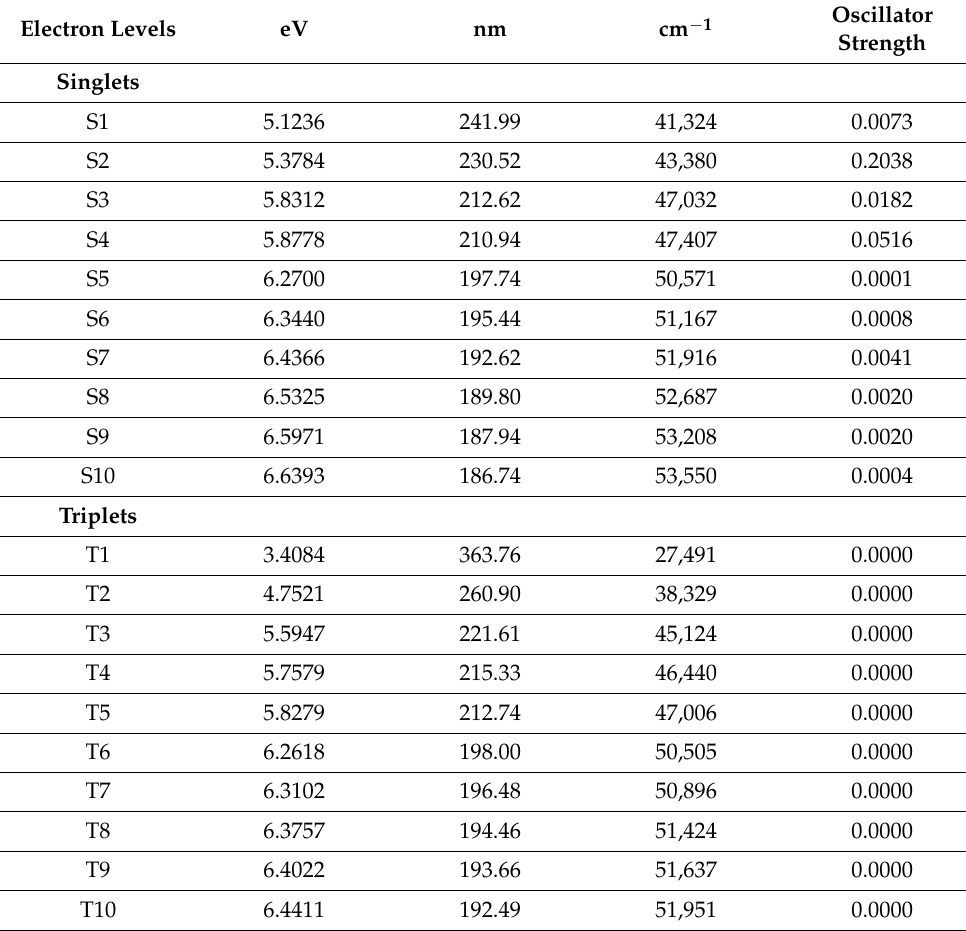
Table 5. Calculated singlet and triplet electron levels of loganic acid in the monomeric